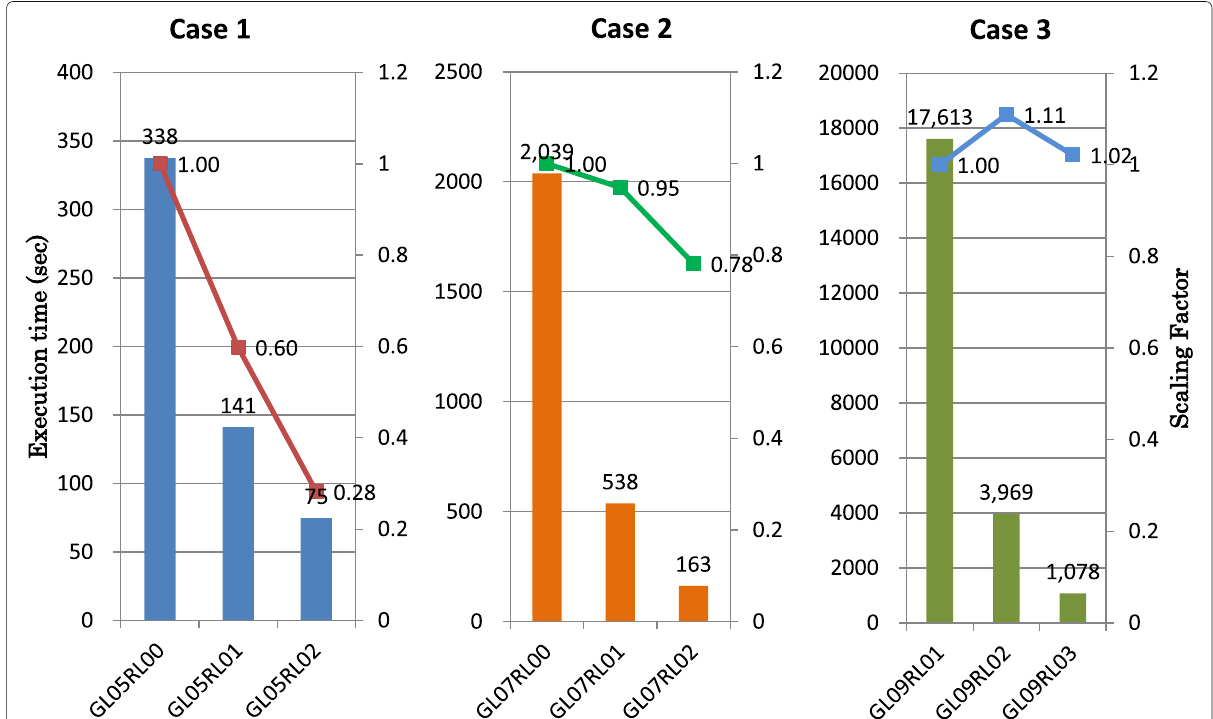
Fig. 8 Execution time and scaling factor of “Atmos.” Bar graph illustrates execution time (s). Line graph represents scaling factor vibrate the building (Matsumoto et al. 2015). Figure 11 this case, the data exchange is one-way, from the seismic shows the grid used by the structure model for this calcu- lation. The grid is largely divided into a part representing the building and a part representing the ground, and the ground grid is embedded in the seismic model grid. In